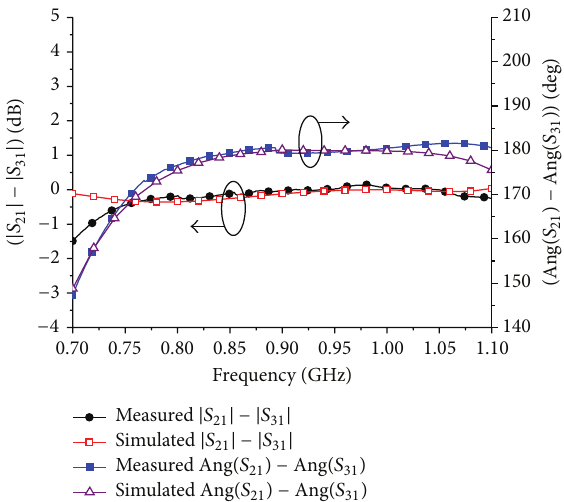
Figure 10: Measured and simulated phase differences and magni- tude differences of output